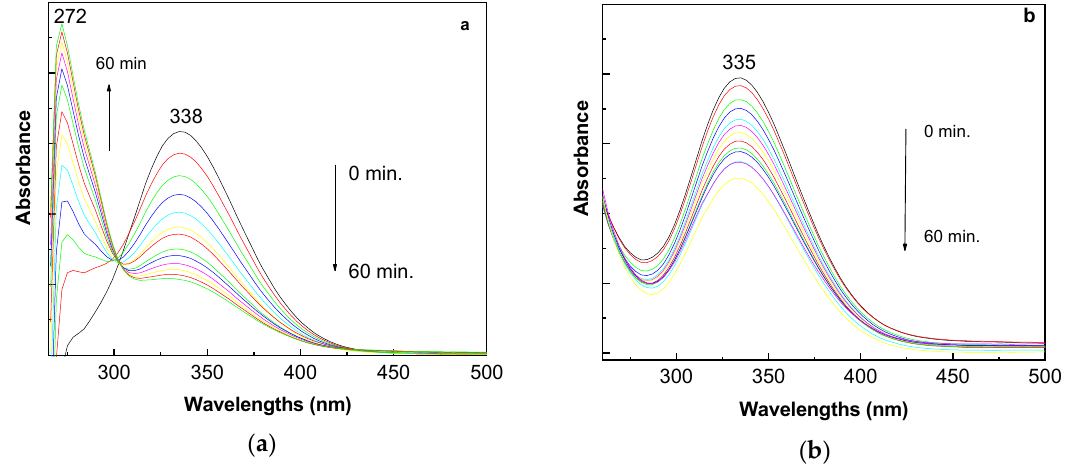
Figure 1. UV-VIS spectra of α -lipoic acid (ALA) in dimethyl formamide (DMF) ( a ) and in the mixture of DMF–H 2 O with the volume ratio equal to 1:1 ( b ). The concentration of ALA is 1 mg/mL. The two samples' UV-VIS spectra were recorded at intervals of 5 min of exposure to UV light, for 60 min.